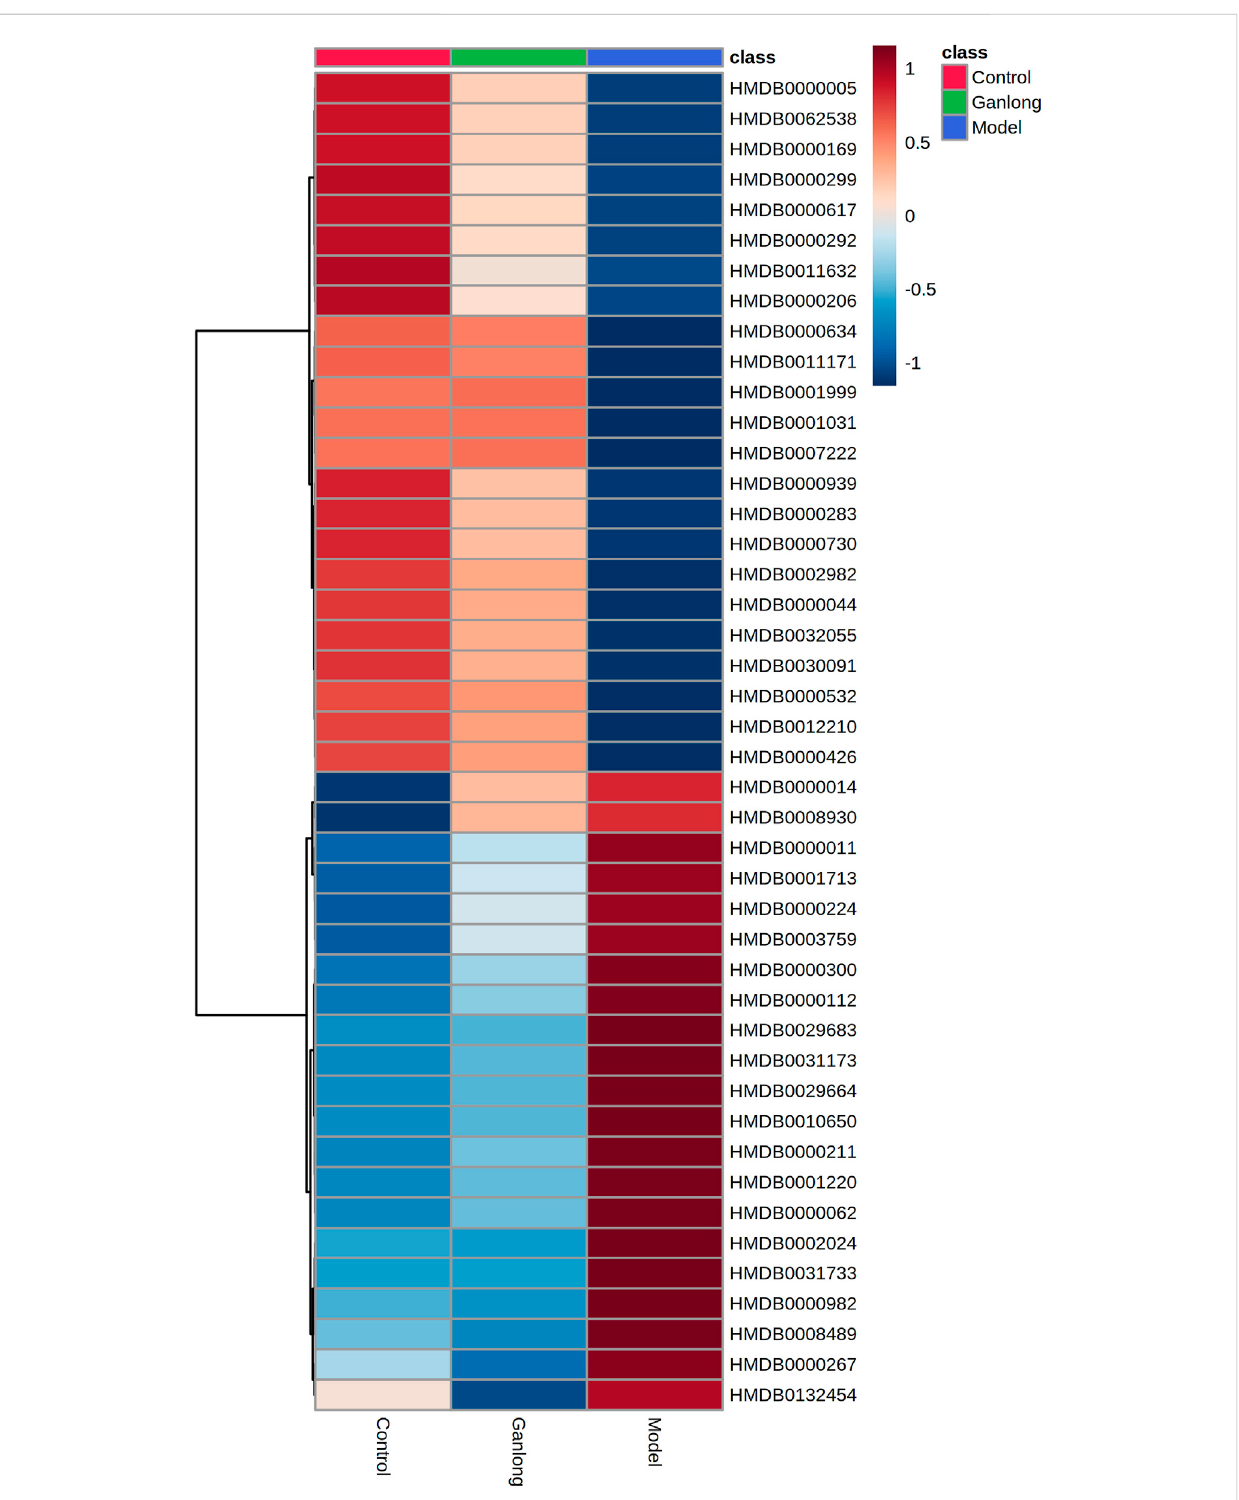
FIGURE 5 Heat map of potential biomarker expression in liver tissue of rats in each group. Control group, model group and Ganlong capsule treatment group ( n =6). Model group compared with normal control group, * p < 0.05, ** p < 0.01; Ganlong capsule group compared with model group, # p < 0.05, ## p <